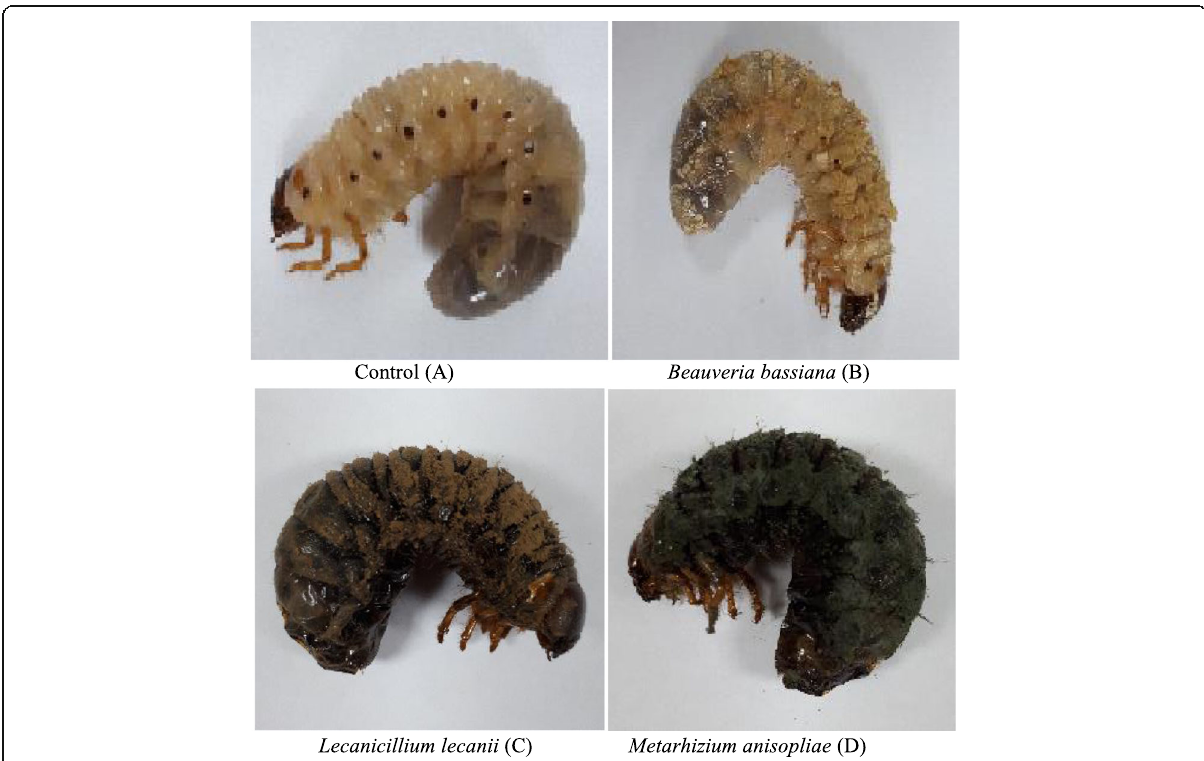
Fig. 1 Mycelial growth on mycotic larval cadavers of Oryctes agamemnon that died due to infection with EPF isolates: control ( a ), Beauveria bassiana ( b ), Lecanicillium lecanii ( c ), and Metarhizium anisopliae ( d )